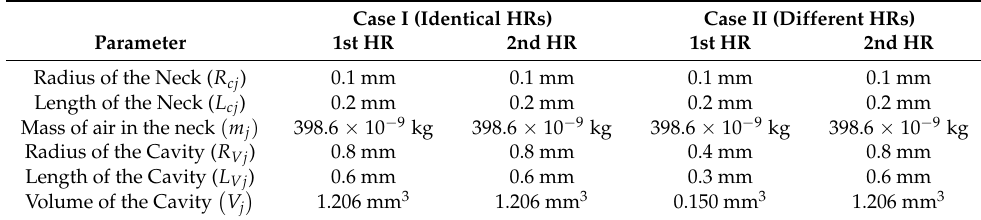
Table 2. The construction of the small-size dual nonlinear